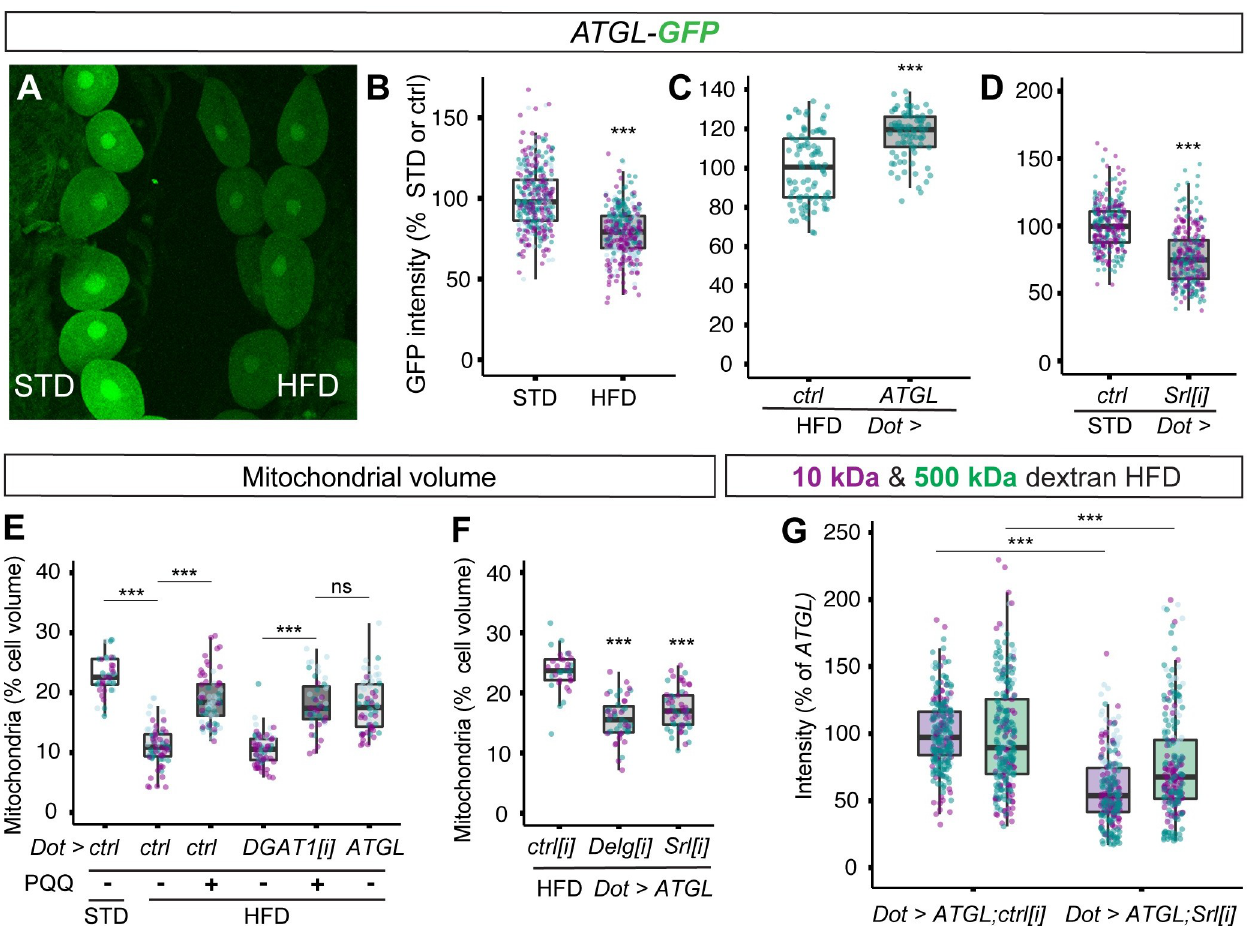
Fig 6. Rescue of nephrocyte mitochondria and endocytosis on HFD requires PGC1 α /Srl. ( A–D ) C onfocal micrographs of nephrocytes and quantifications showing that ATGL-GFP reporter expression is suppressed by HFD (A, B), restored by Dot > ATGL (C), and decreased by Dot > Srl[i] on STD diet (D). Note that the GFP intensities of HFD and STD nephrocytes can be directly compared in panel A because they are both imaged within the same field of view. ( E ) Dietary supplementation with PQQ rescues nephrocyte mitochondrial volume on HFD, in control or Dot > DGAT1[i] genotypes, back to a value similar to that in HFD Dot > ATGL or STD larvae. ( F ) Dot > ATGL rescue of nephrocyte mitochondrial volume is compromised by simultaneous knockdown of PGC1 α ( Dot > ATGL;Srl[i] ) or Delg ( Dot > ATGL;Delg[i] ). ctrl[i] refers to UAS-mCherry[i] . ( G ) Dot > ATGL rescue of 10-kDa and 500-kDa dextran uptake on HFD is blocked by simultaneous knockdown of PGC1 α ( Dot > ATGL;Srl[i] ). ctrl[i] refers to UAS-mCherry[i] . See S1 Data for details of p -values and the type of statistical model used for all graphs in this study. S2 Data provides the source data used for all graphs and statistical analyses. ATGL, adipose